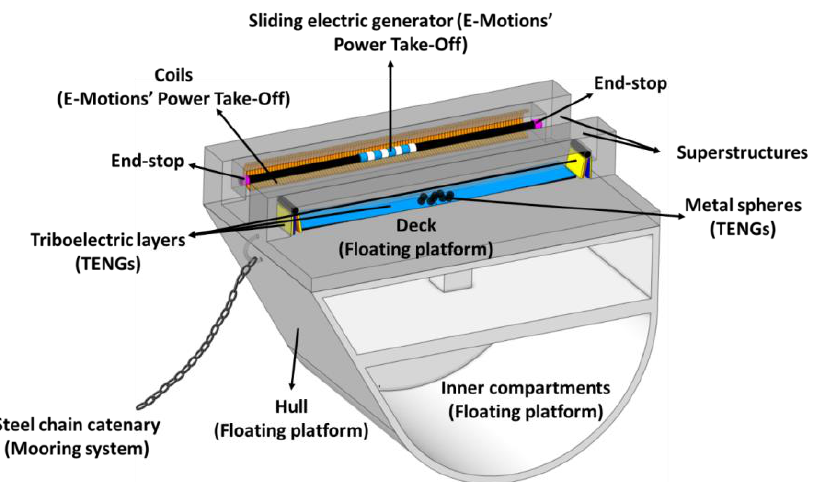
Figure 1. Conceptualization of E-Motions with integrated triboelectric nanogenerators. The inner compartments can also accommodate either the E-Motions’ PTO or the TENGs.